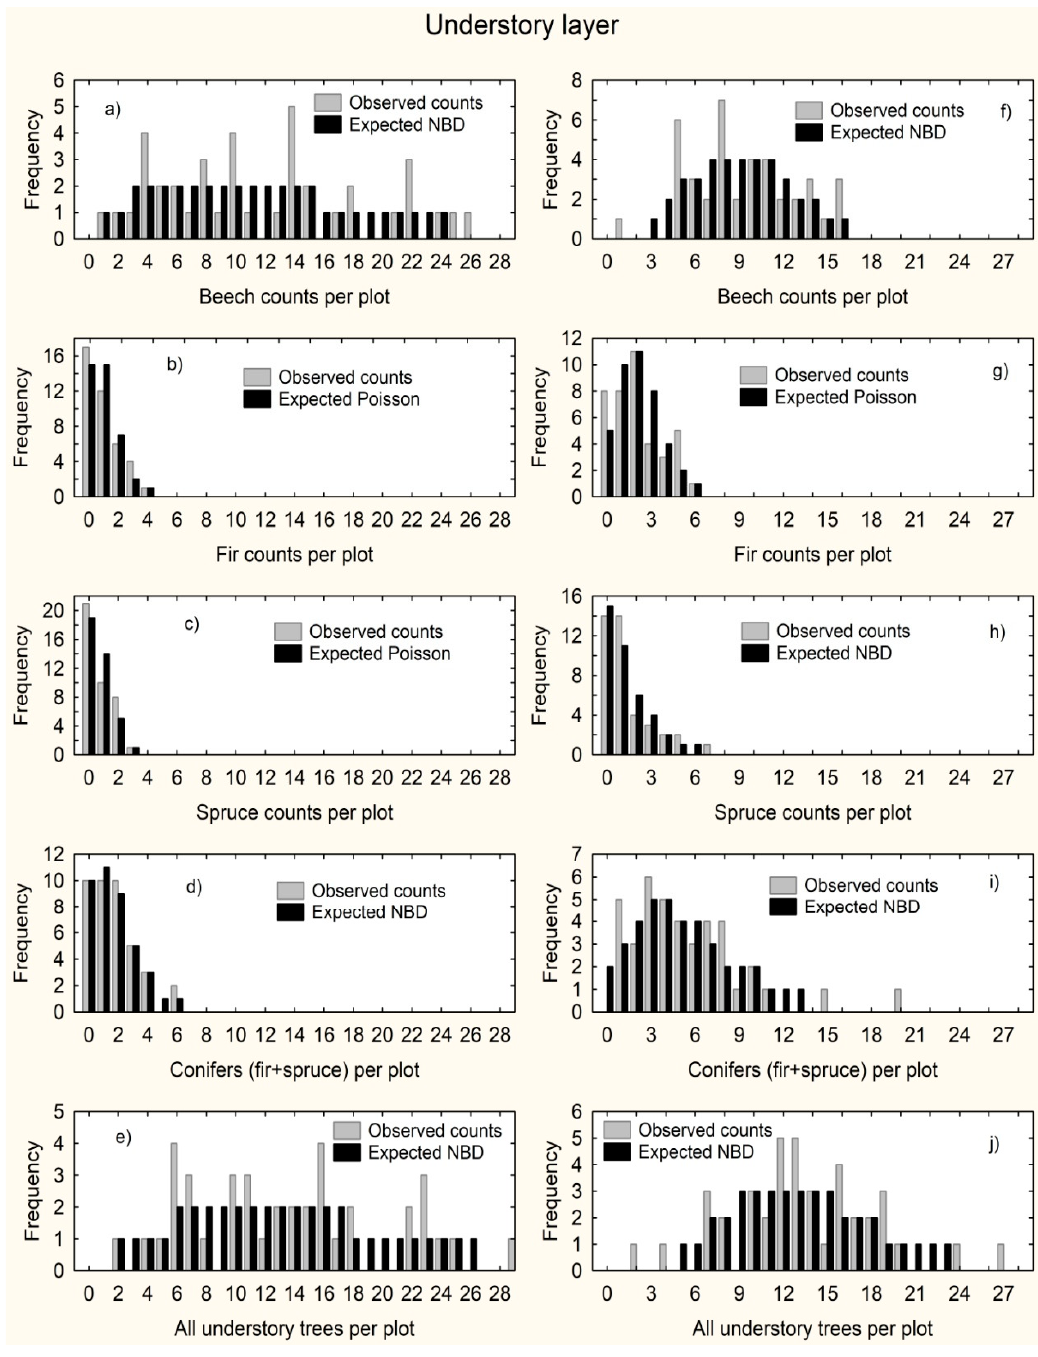
Figure 1. The observed and expected tree counts for individual tree species, for conifers combined, and for all species combined in the understory layer (7.5–27.5 cm diameter at breast height (DBH)) in the Janj (left: a – e ) and Lom (right: f – j ) old-growth forests. The expected counts were shown based on the models that best fitted the observed counts: negative binomial distribution (NBD) and Poisson distribution.